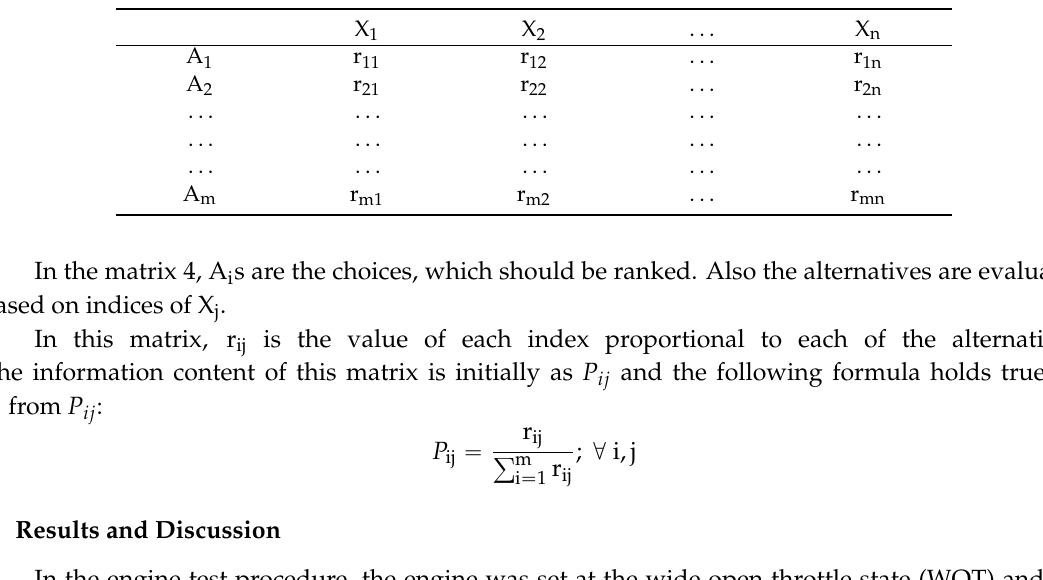
Table 4. General Model of a decision-making